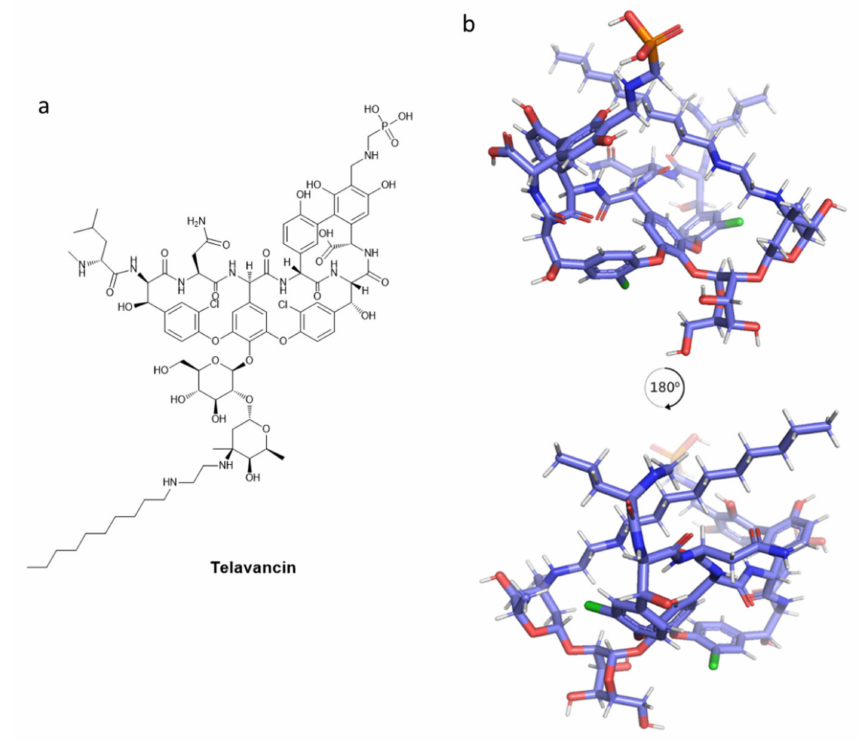
Figure 9. ( a ) Telavancin 2D structure and ( b ) 3D conformation of the minimized structure of telavancin (purple) that was obtained with